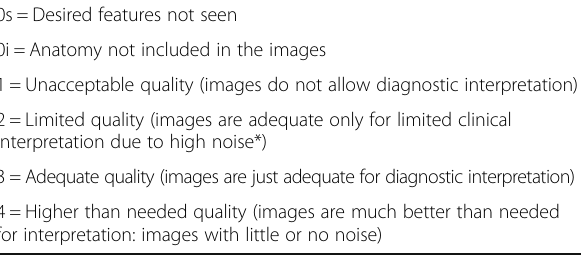
Table 1 Scoring chart for image quality scoring criteria